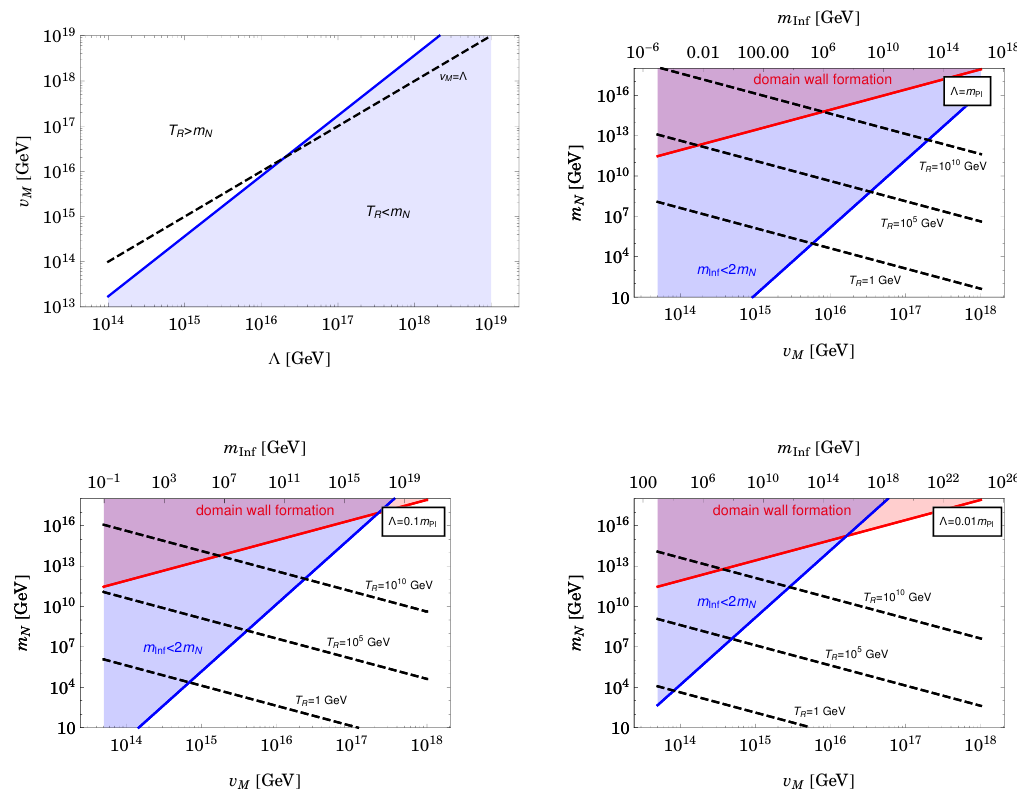
Figure 2 . The allowed regions (in white) of the parameter space for n = 6. Upper left: this plot shows the values of v M as a function of (cid:3) such that T R > m N , i.e. the right-handed neutrinos thermalize. The dashed black line indicates v M = (cid:3). Therefore, if we impose the (cid:13)avour symmetry breaking scale to be lower than the cuto(cid:11) scale (cid:3), only the white area between the blue line and the dashed line for (cid:3) . 10 16 GeV is allowed. Upper right: the allowed parameter space (in white) for n = 6 and (cid:3) = m Pl . The blue shaded area is excluded due to the kinematic condition m Inf > 2 m N , and the red shaded area is excluded due to domain wall formation. The three dashed lines are the lines of constant reheat temperature 1 GeV, 10 5 GeV and 10 10 GeV, respectively. Lower left and lower right: the same plots for (cid:3) = 0 : 1 m Pl and (cid:3) = 0 : 01 m Pl ,